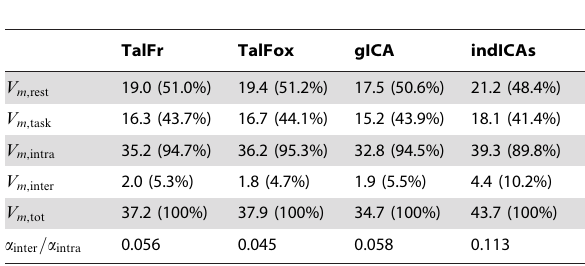
Figure 7. The effect of method was mostly concentrated on the of method on the other components was found at a threshold of Table 6. Inhomogeneity as a measure of intraclass and interclass